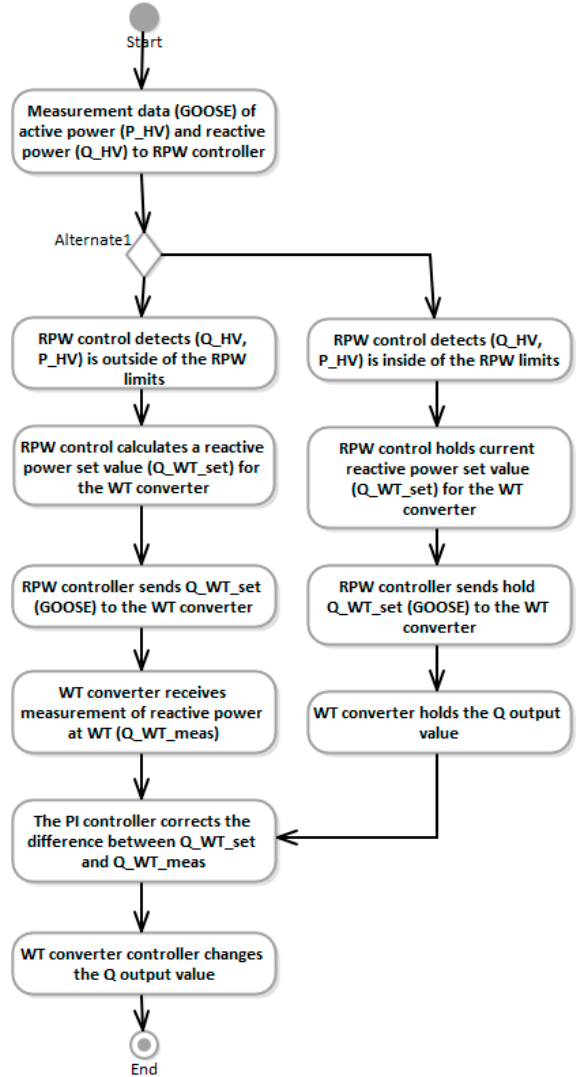
Figure 16. Reactive power control in the Sundom Smart Grid—activity diagram of RPW control for the technical ancillary services TUC.